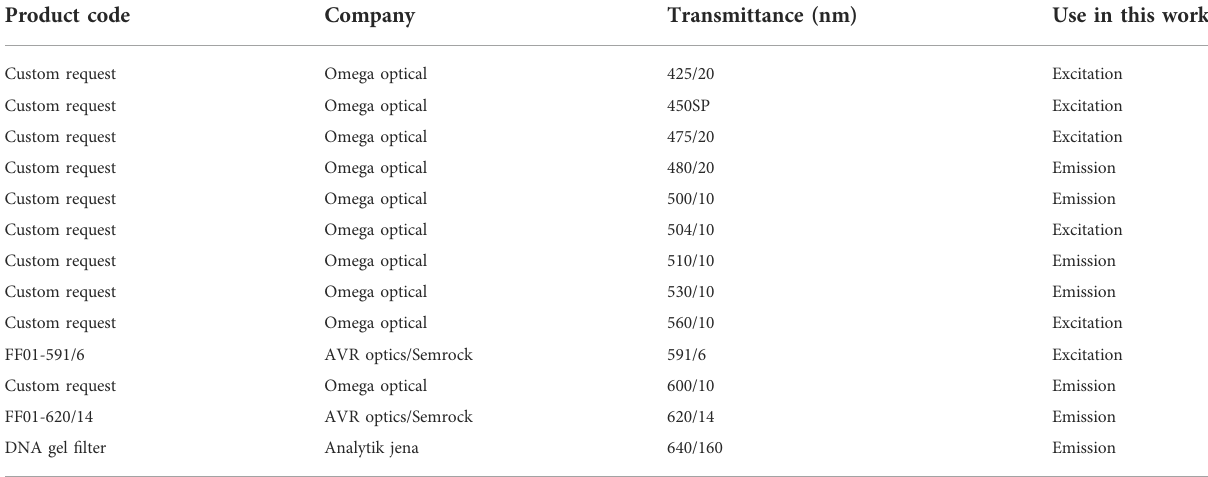
TABLE 1 Optical properties, use, and sources of fi lters tested in this work.